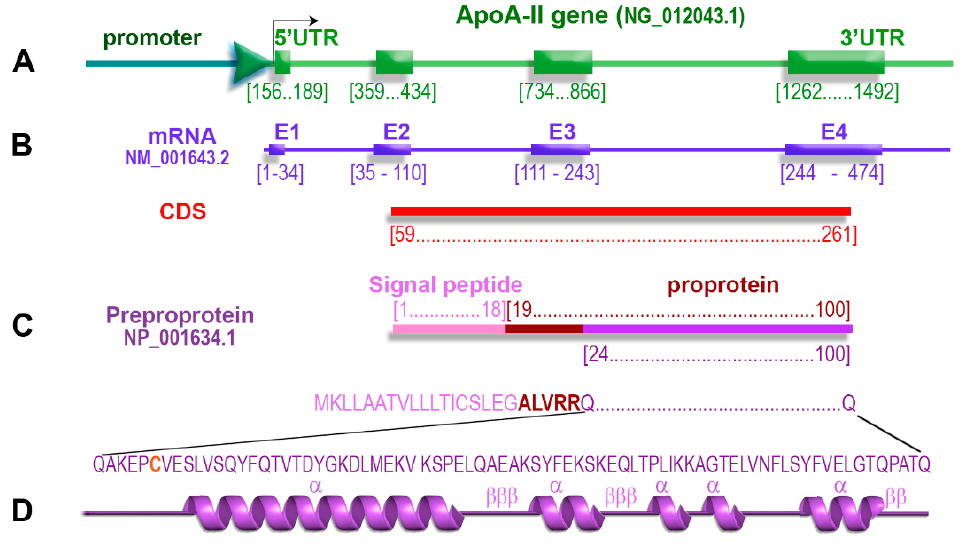
Figure 1. The structure of the human ApoA-II gene. ( A ) Schematic illustration of ApoA-II gene containing the promoter, 5 (cid:48) UTR (untranslated 5 (cid:48) region), four exons, three introns, and 3 (cid:48) UTR (untranslated 3 (cid:48) region). ( B ) The mRNA of ApoA-II transcribes all four exons (E1–E4). The coding sequence of the apoA-II gene spans from the second exon to the fourth exon, respectively, from position 59 to 261. ( C ) The preproprotein consists of the signal peptide of 18 amino acids and the proprotein. ( D ) Mature apoA-II protein is formed after the proteolytic cleavage of the ALVRR sequence, and its 77 amino acid sequence is indicated. Human apoA-II has a single cysteine residue (Cys6) involved in the formation of heterodimers with other apolipoproteins. ApoA-II contains amphipathic α -helices in tandem, which are connected through β -turns. Abbreviations: UTR, untranslated region; E, exon; CDS, coding sequence; α , α -helix; β , β -turn.